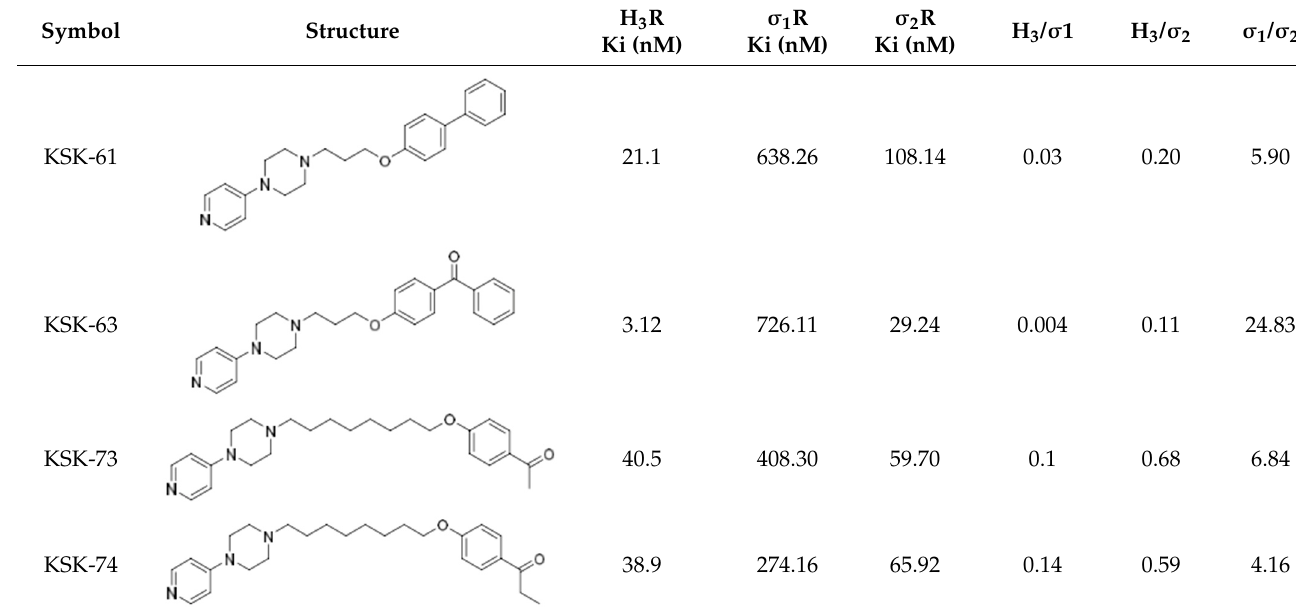
Table 4. Structures and affinities to primary targets of tested compounds [25].